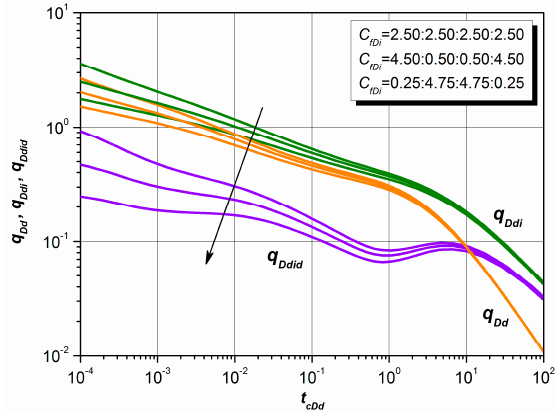
Figure 9. The effect of unequal fracture conductivity on combined type curves of an MFHW.